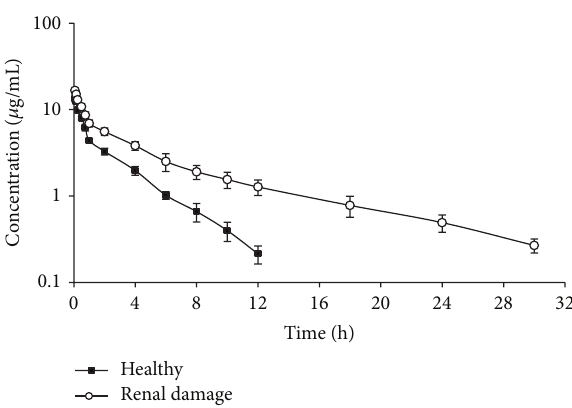
Figure 1: Semilogarithmic plot of the observed mean ± SE depicting the time and concentration of levofloxacin in plasma of healthy ( ◼ ) and renal damaged ( ] ) ducks after a single IV administration of 10 mg kg −1 bwt ( 𝑛 = 6 ).